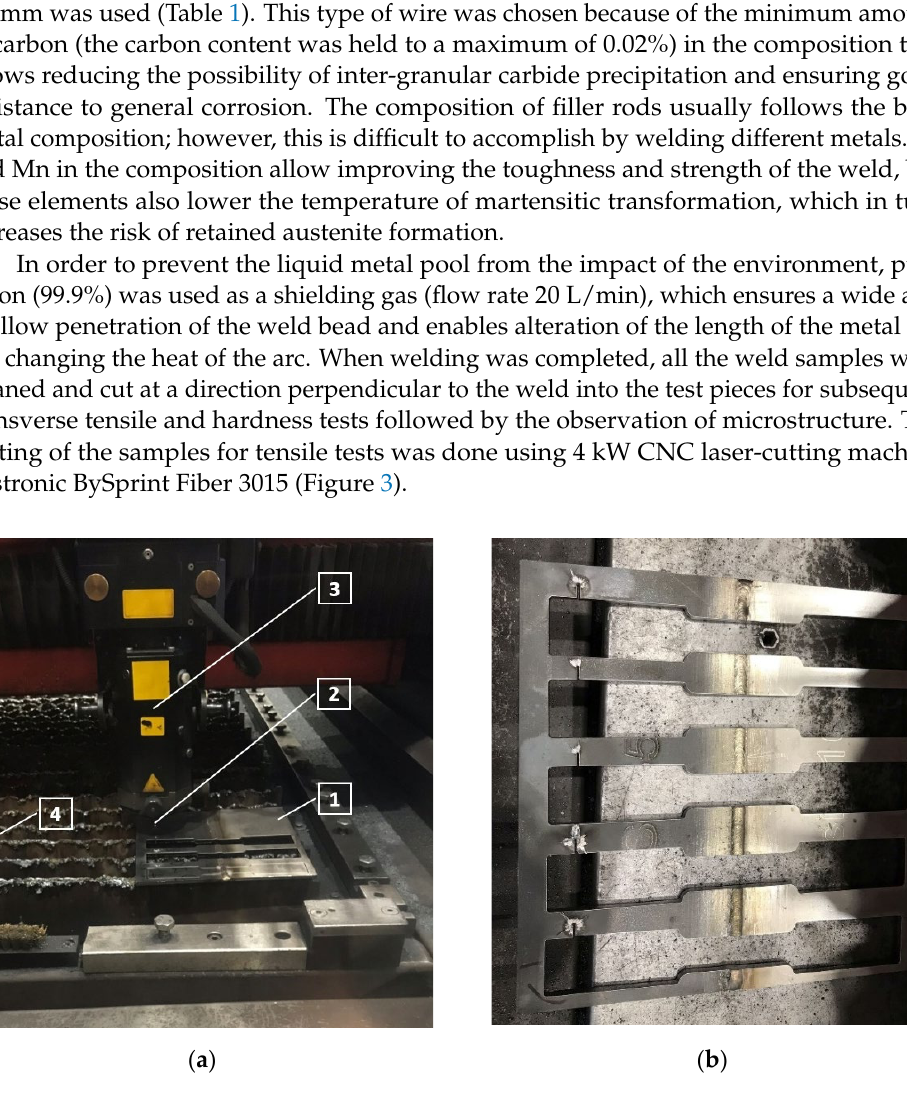
Figure 3. Laser cutting of the tensile samples: ( a ) cutting process with CNC laser-cutting machine: 1—workpiece; 2—nozzle; 3—laser cutting head; 4—workpiece supports; ( b ) dissimilar weld samples after laser cutting.